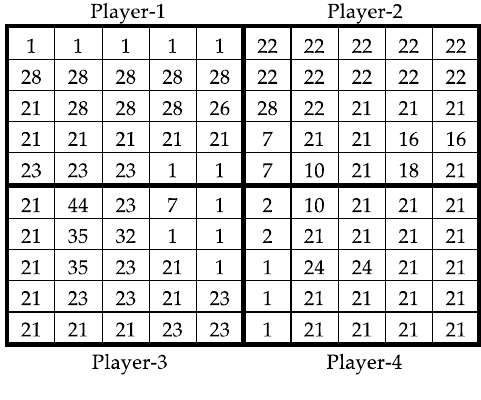
Figure 2. Players and Land Grid.